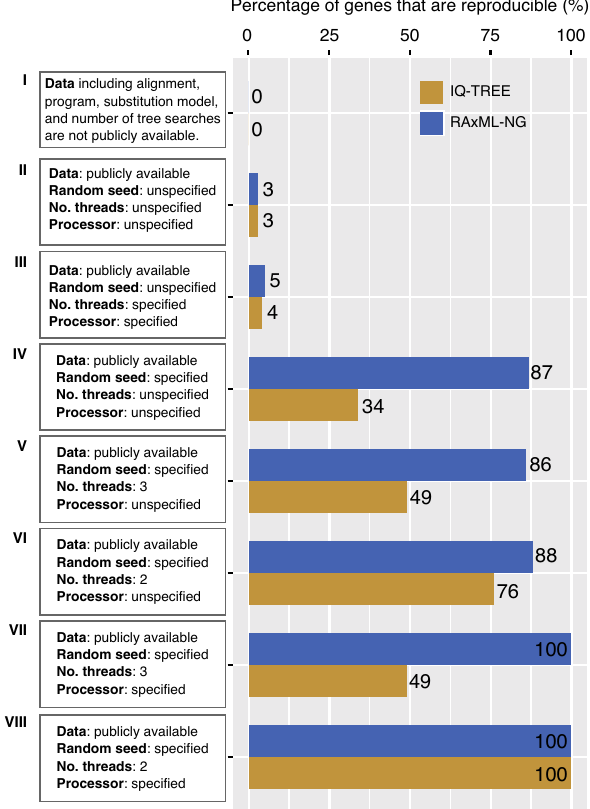
Fig. 7 An overview of the reproducibility of phylogenetic inference. The